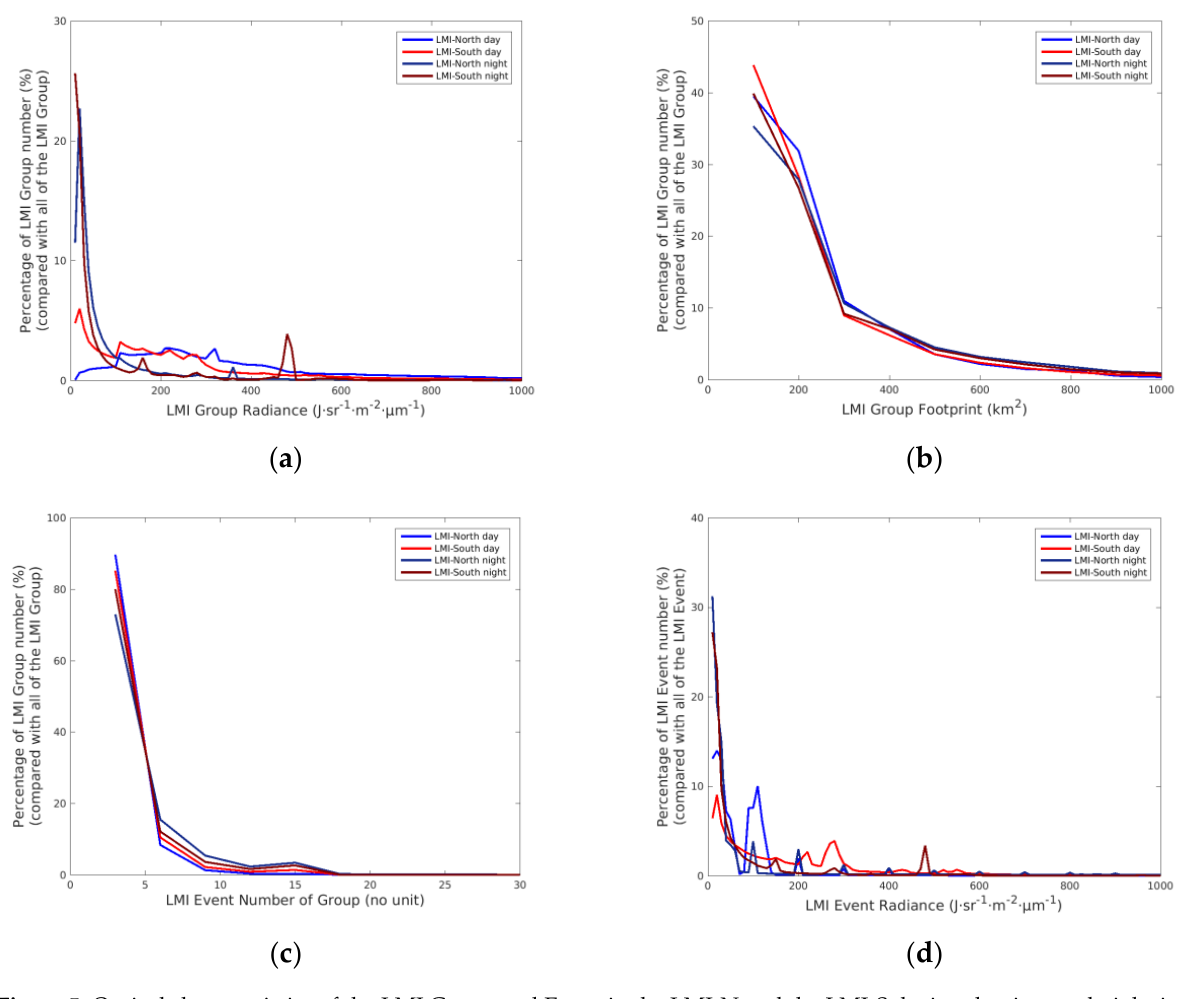
Figure 5. Optical characteristics of the LMI Group and Event in the LMI-N and the LMI-S during daytime and nighttime. ( a ) Group Radiance, ( b ) Group Footprint, ( c ) Group-Event (each Group consists of Event) number, and ( d ) Event Radiance.